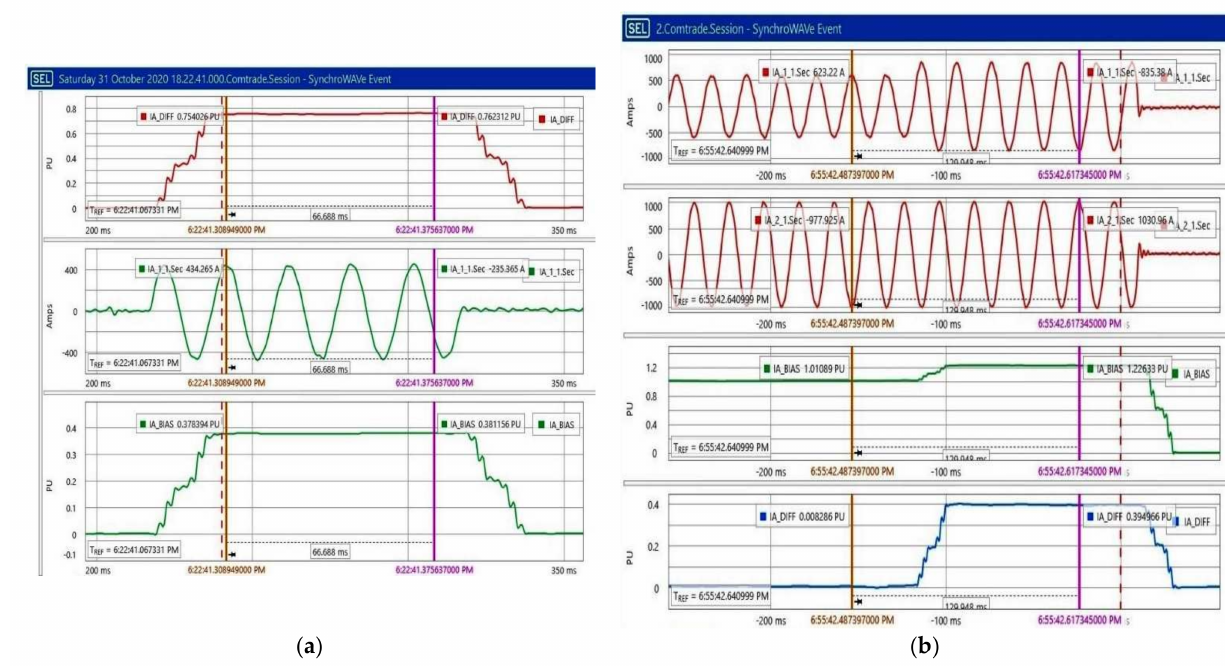
Figure 11. Waveform of: ( a ) Red Phase Current, I dif f and I bias of red phase for fault simulated in trip time test, ( b ) HV and LV Red Phase Current, I dif f and I bias for point D of Figure